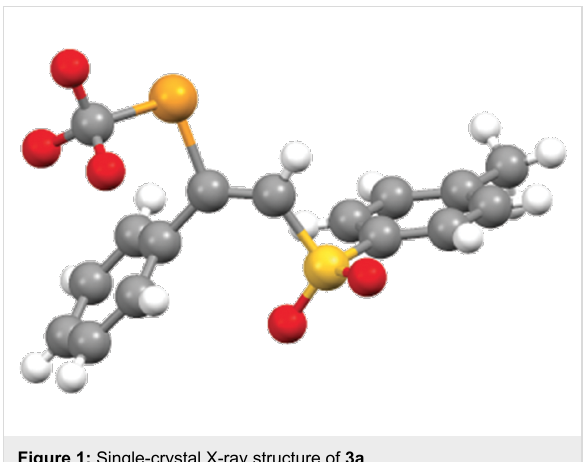
From a mechanistic point of view, the reaction starts certainly with the intermediate formation of the trifluoromethylseleno- nium ion I . This is in accordance with the observed trans- selec- tivity due to the anti opening of I by the toluenesulfinate anion. The regioselectivity could be rationalized by the steric hindrance between the aromatic moiety and the large nucleo- phile (toluenesulfinate anion) which favors the attack on the less hindered side (Scheme 2, pathway a). Such sensitivity to steric hindrance of I was confirmed by the lack of reactions ob- served with internal